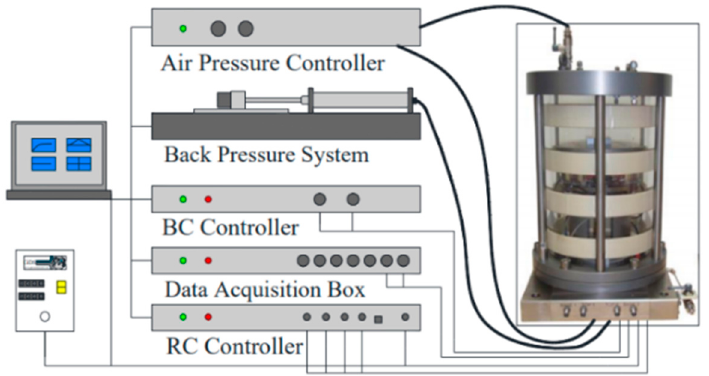
Figure 3. Schematic diagram of the general assembly of the unsaturated BE-RC test system.